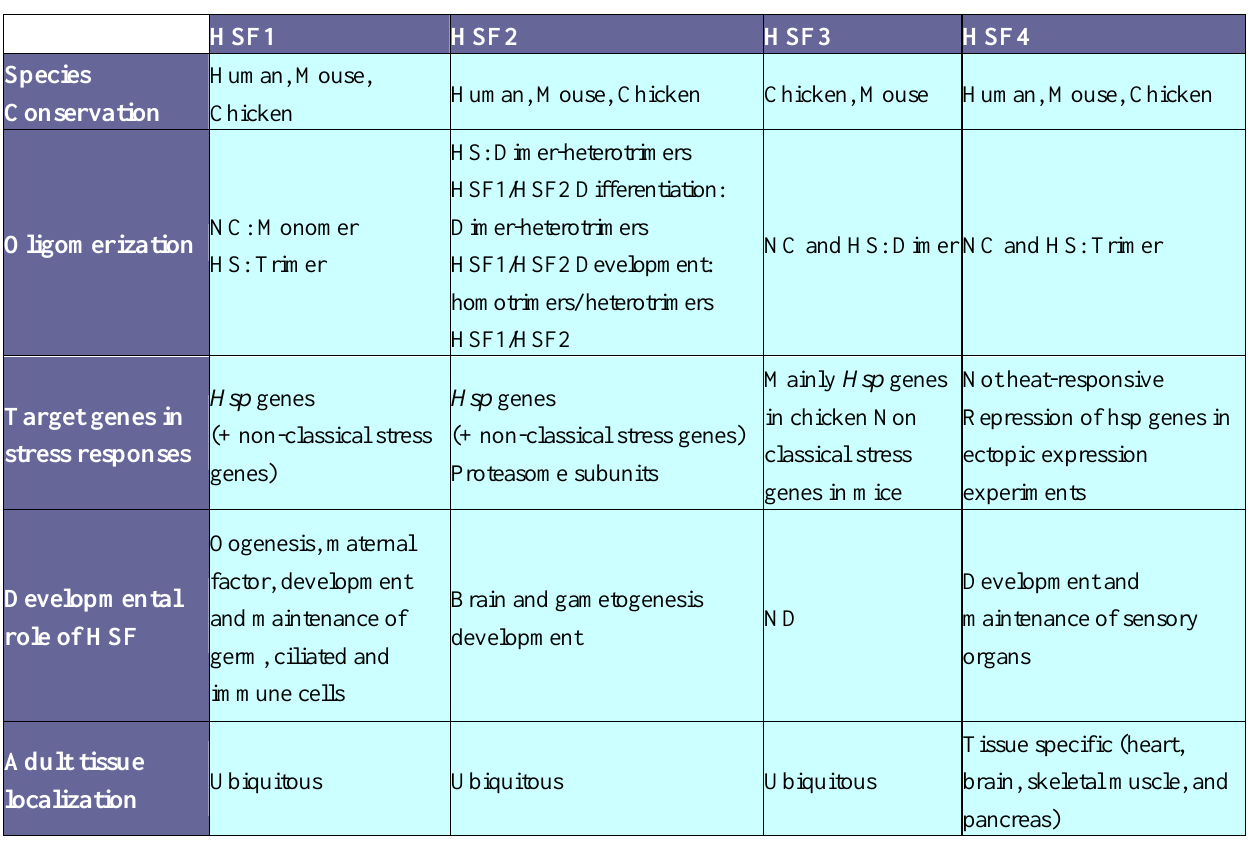
Table 1. HSF main